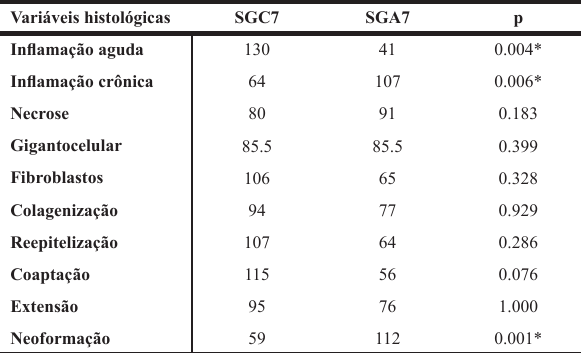
TABELA3 – Teste não-paramétrico de Mann-Withney - 7º dia do pós-operatório